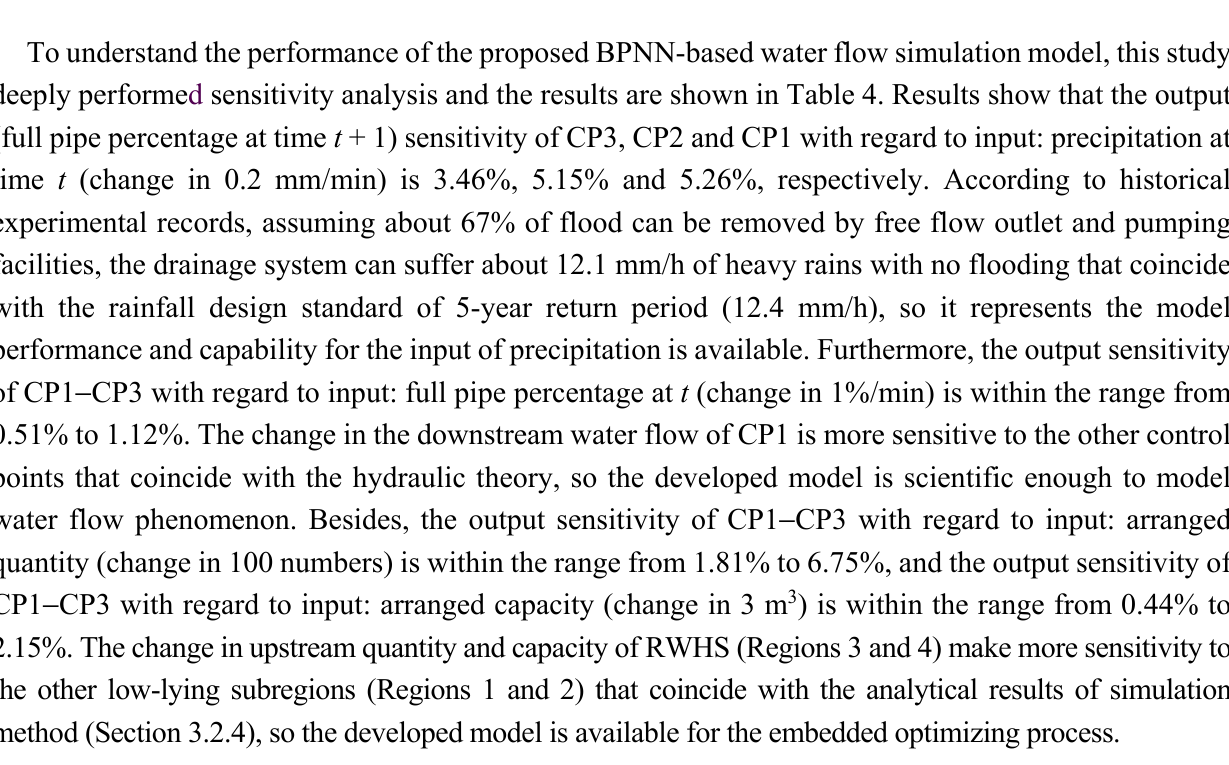
Table 4. Sensitivity analysis of the backpropagation neural network (BPNN)-based water flow simulation